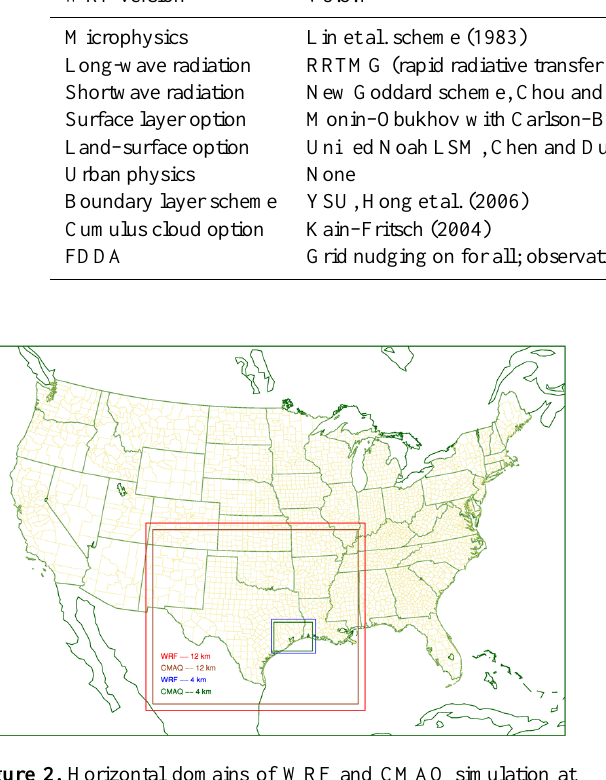
Figure 2. Horizontal domains of WRF and CMAQ simulation at 4 and 12km grid resolution (the bigger domains are for 12km WRF and CMAQ and the smaller domains for 4km WRF and